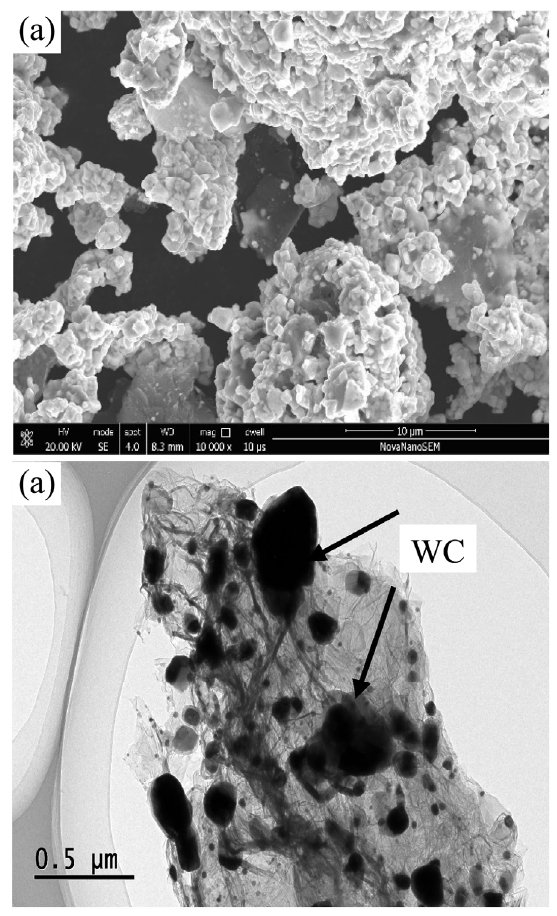
Fig. 3 Morphology of graphene in the composite spray powder: (a) SEM image of the grapheme and (b) TEM image of the